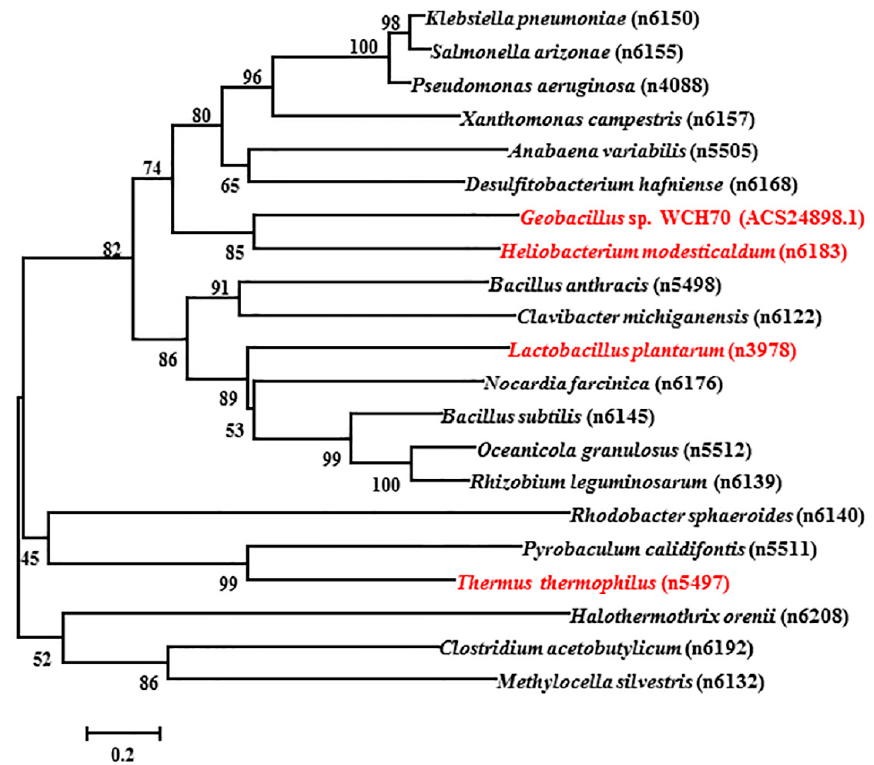
Figure 1. Phylogenetic tree of the species of new GWC ( Geobacillus sp. WCH70 catalase) and 20 related